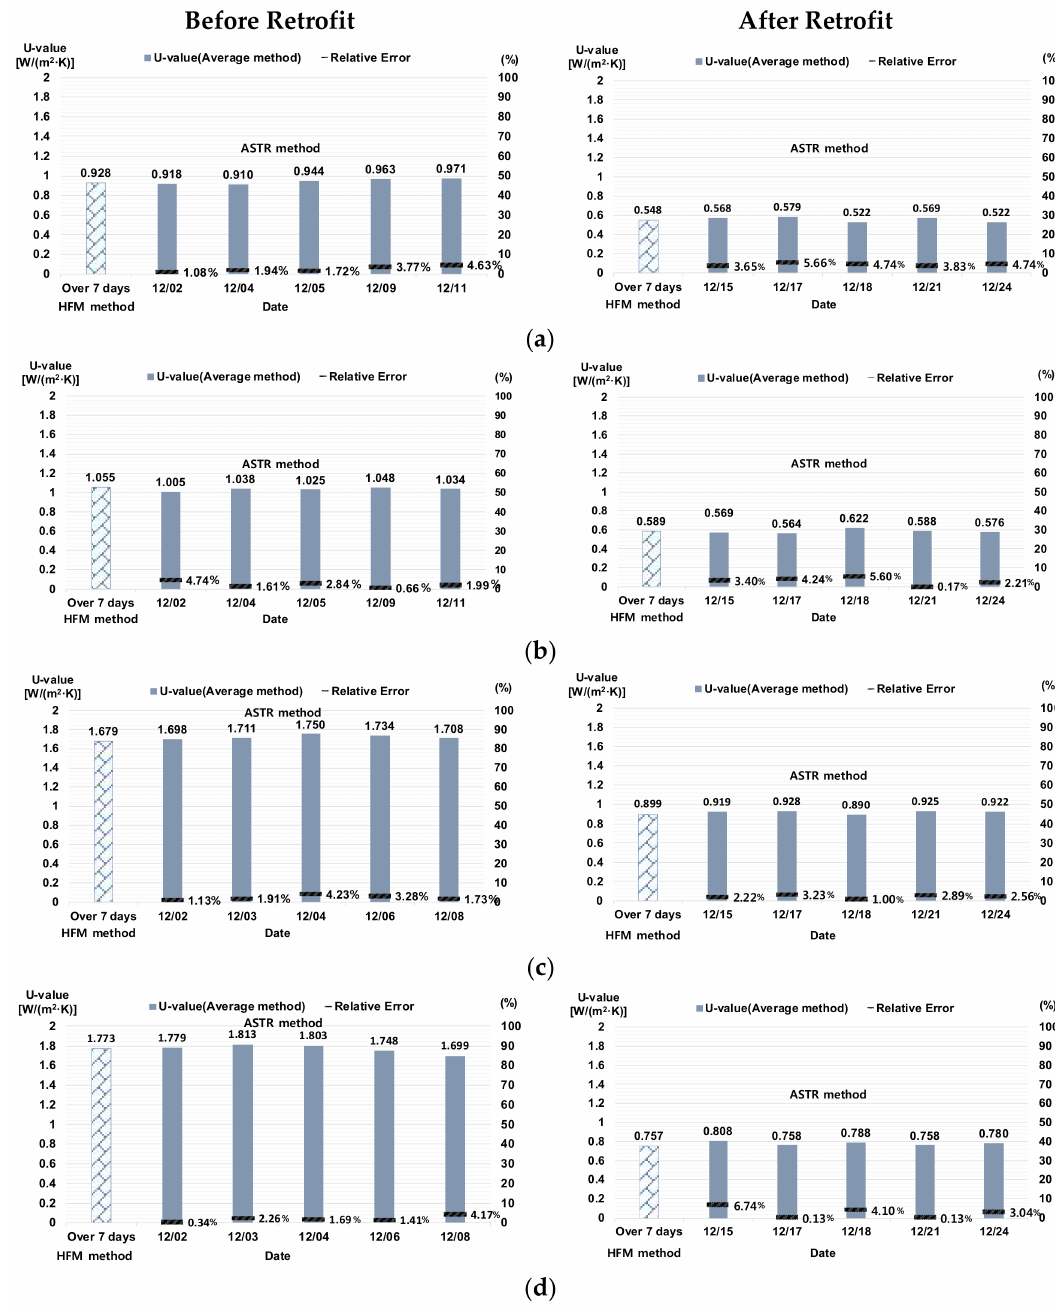
Figure 8. Results of the U-value measurement relative error rates (ASTR method, n = 48): ( a ) Case A; ( b ) Case B; ( c ) Case C; ( d ) Case